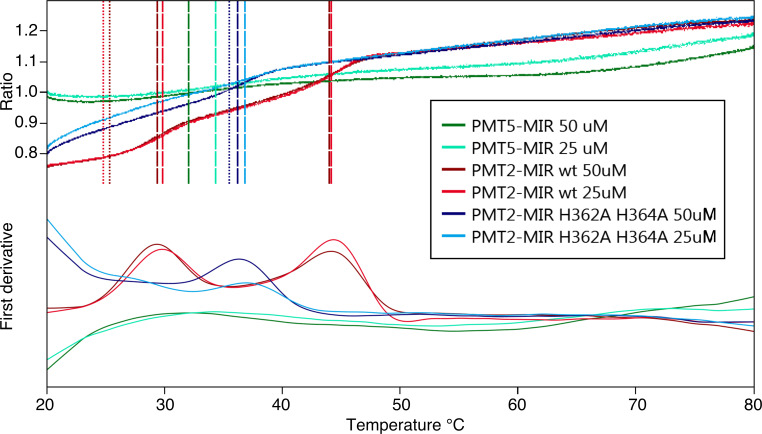
NanoDSF analyses of different Pmt-MIR domains.Data is shown for: Pmt2-MIR domain (red), its mutated variant (site α H362A, H364A, blue) and Pmt5-MIR domain (green). Melting temperatures (Tm) are calculated from peaks in the first derivative of the tryptophan fluorescence ratio (folded/unfolded). While Pmt2-MIR domain dissociates in two steps (two peaks), its mutant has an intermediate Tm, suggesting that the mutation perturbs its stability. Pmt5-MIR of the PMT1 family does not show any defined melting, suggesting that this protein is highly unstable.